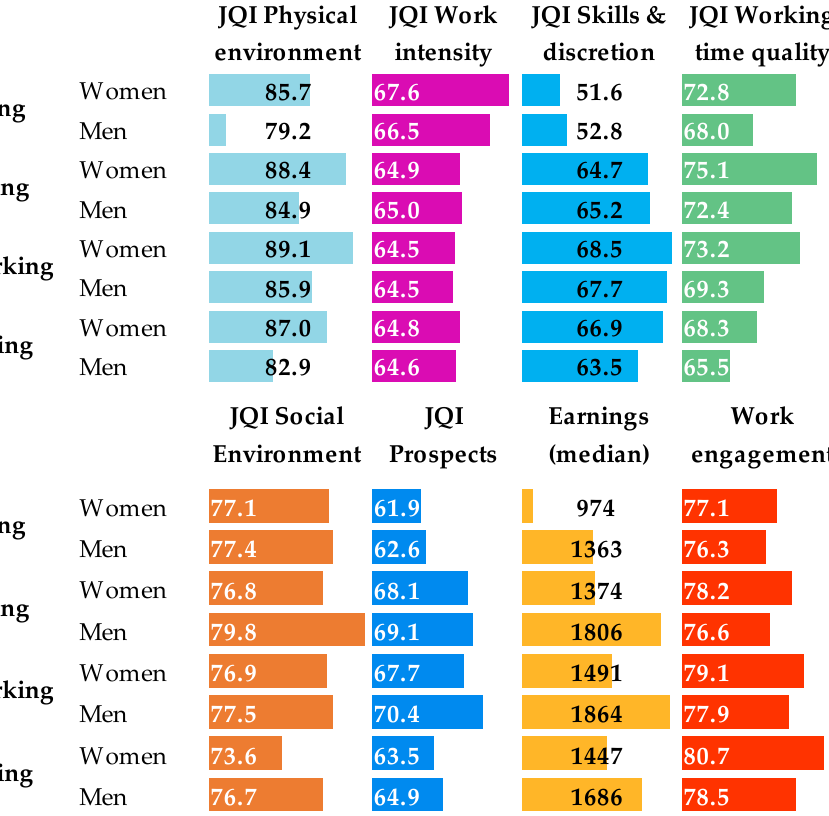
Figure 2. Mean values of each index, by intensity of teleworking and gender, Europe 35 (weighted). Source. Own elaboration based on 6th EWCS data.